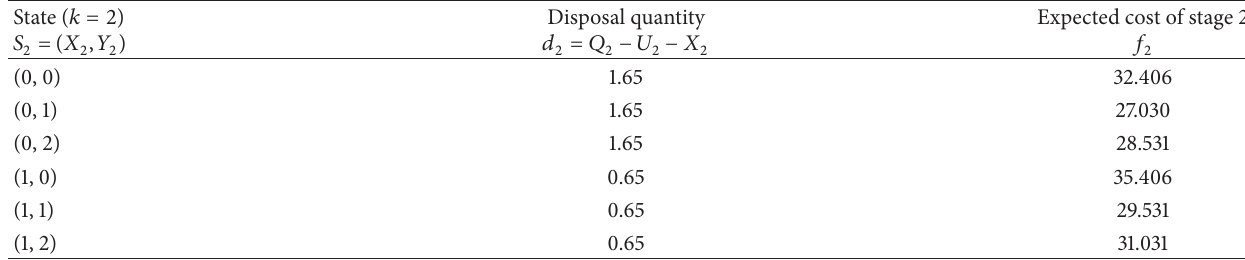
Table 5: The probable state and its expected cost of stage 2.